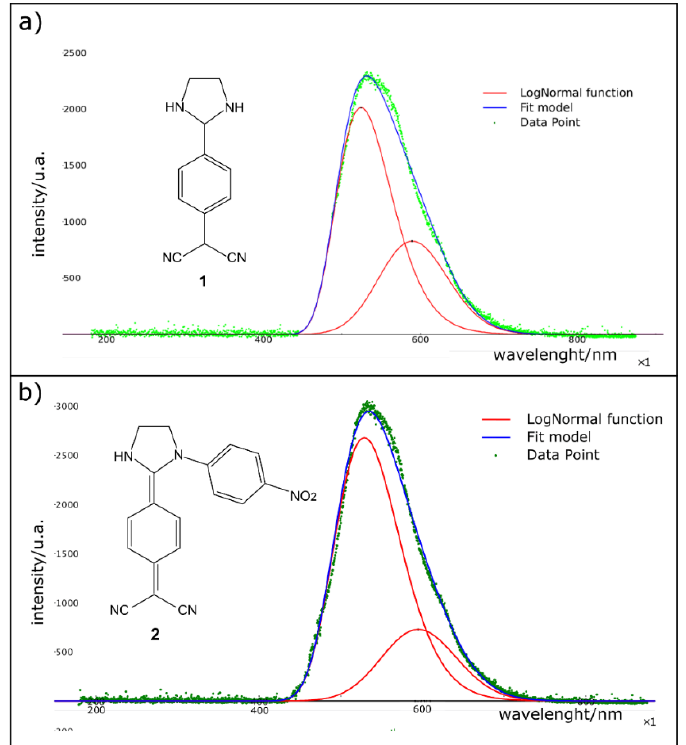
Figure 4. Recorded emission spectra in all the visible range using a diode laser class 3R of 405 nm. ( a ) Emission spectra and its proper deconvolution of molecule 1 ; ( b ) Emission spectra and its proper deconvolution of molecule 2 .